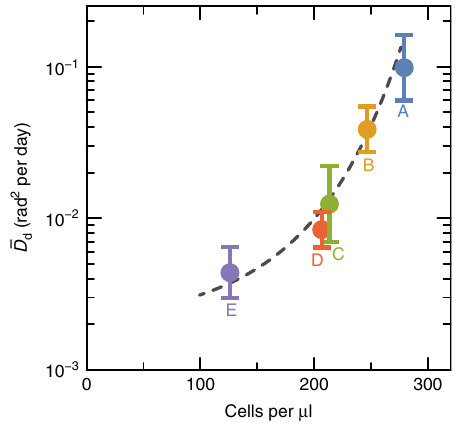
Figure 4 | Dependence of the rotational diffusion coefficient on bacterial concentration. Median rotational diffusion coefficient (cid:2) D d deduced from PDRM zero-field decay curves of the sediment groups A–E (Fig. 3) versus total bacterial concentrations estimated with the spread plate method. The dashed line is a guide for